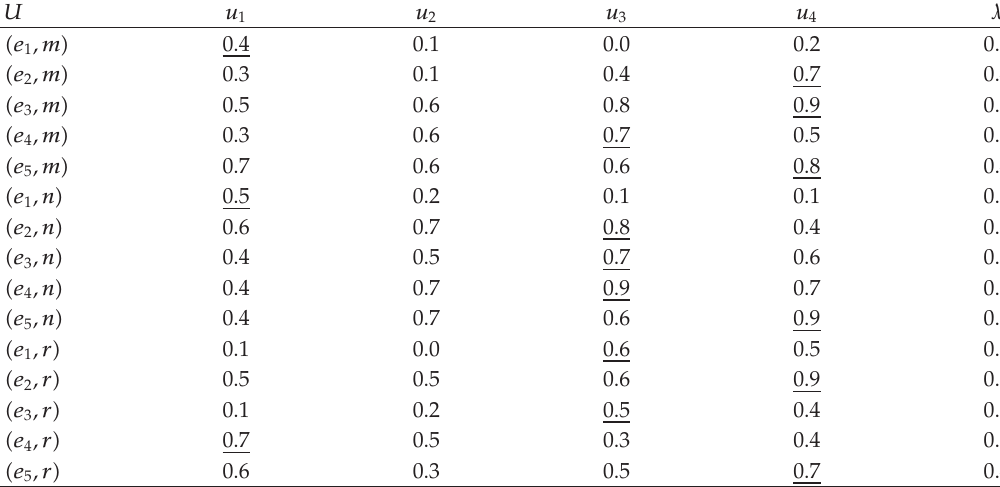
Table 1: Agree-generalized fuzzy soft expert set.